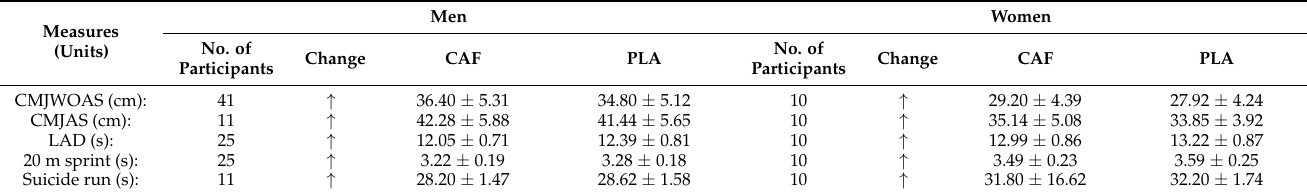
Table A1. Physical performance measures between men and women basketball players following caffeine